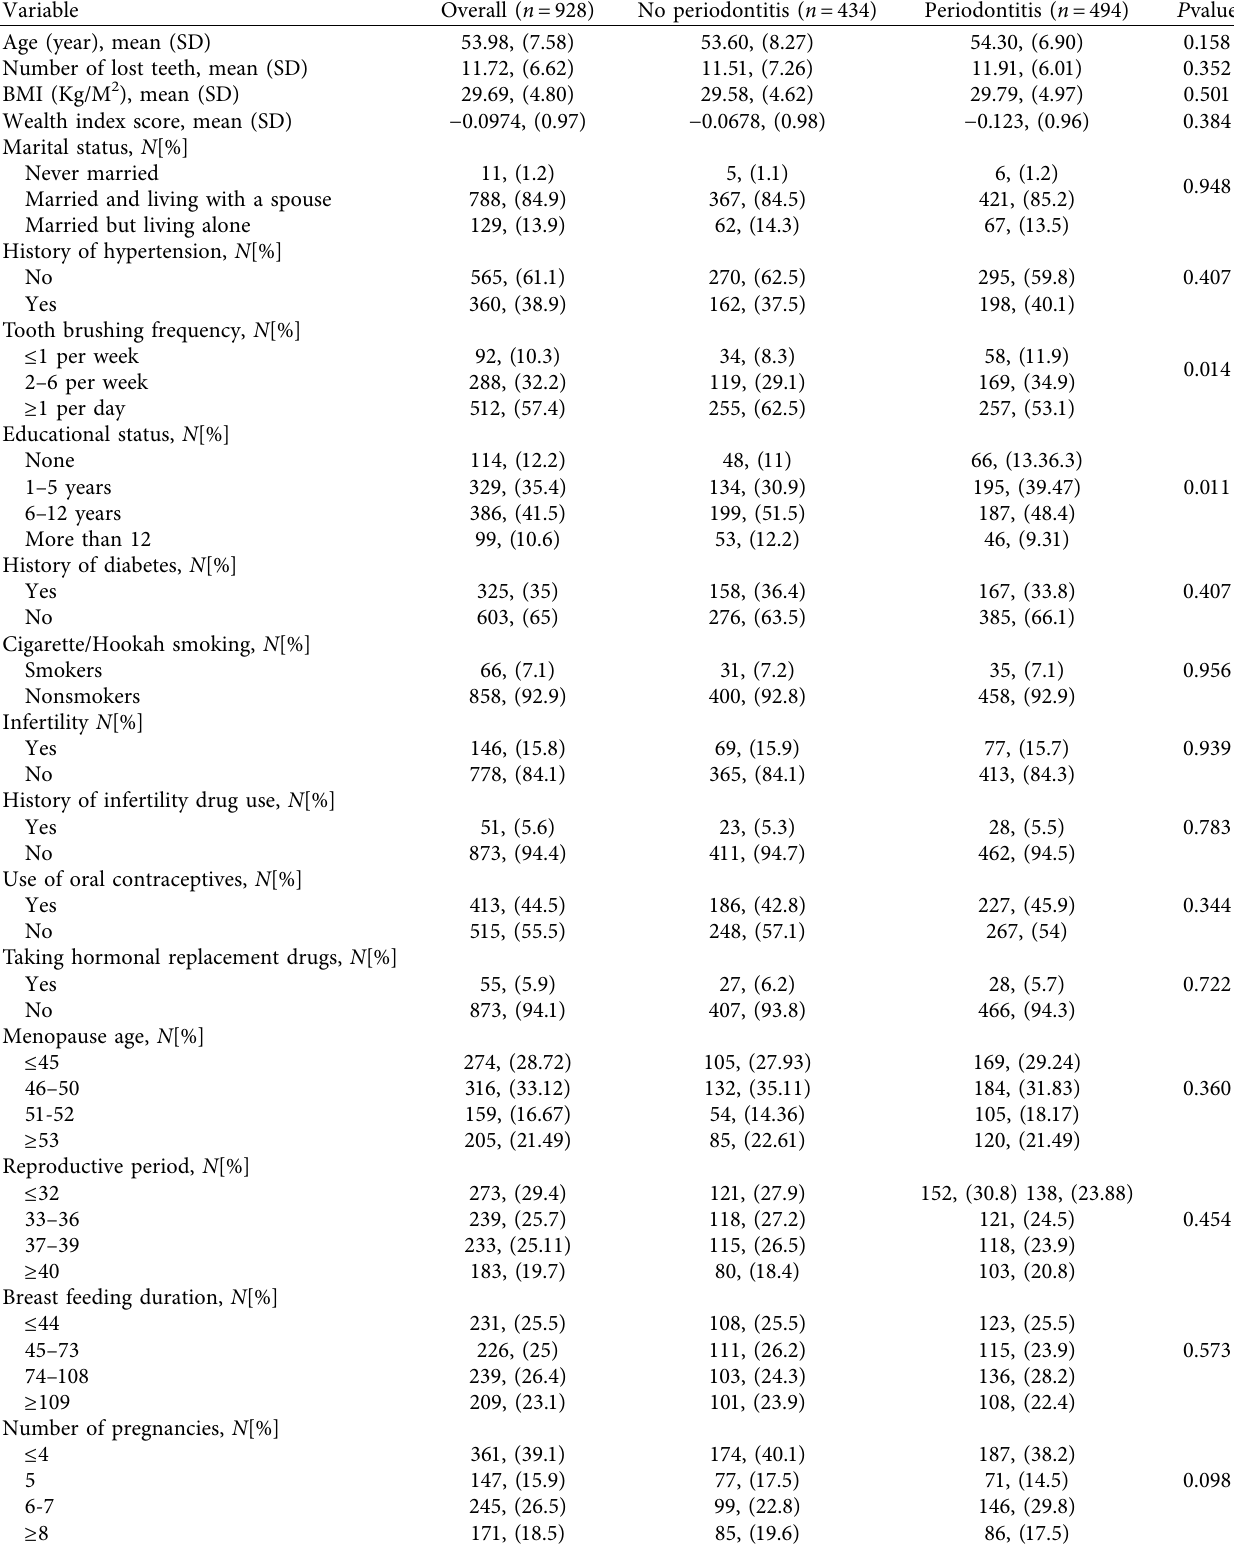
Table 1: Characteristics of the study sample according to the periodontal status ( n �